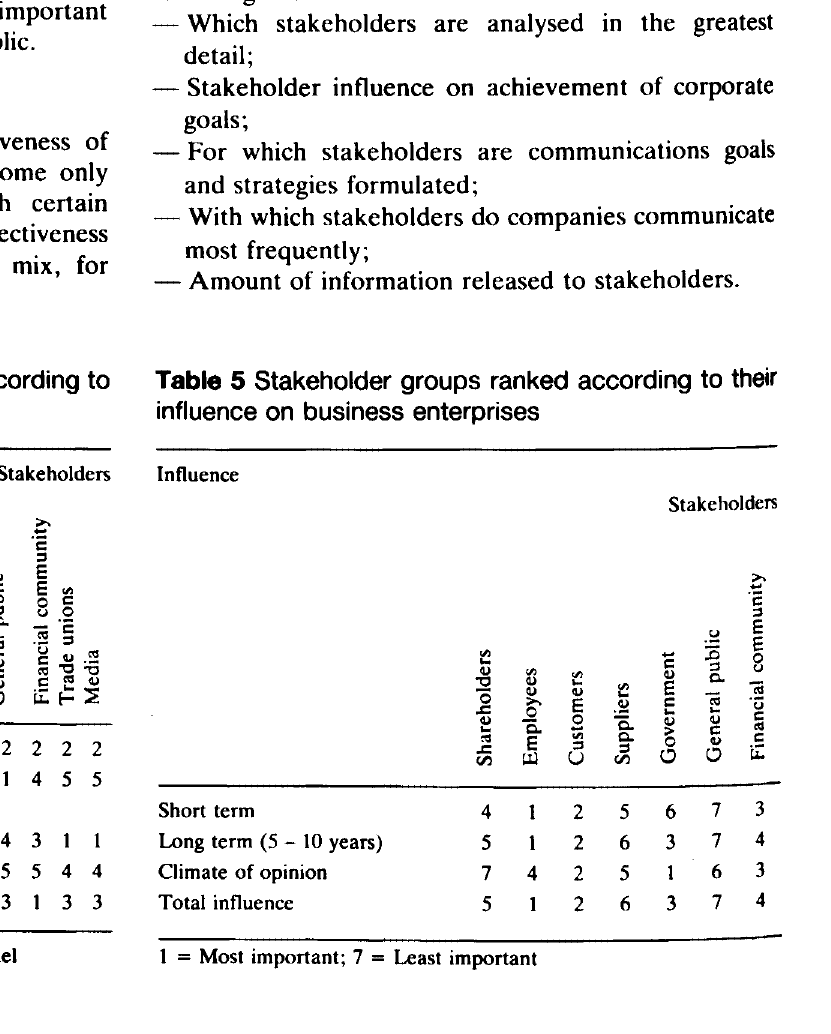
Table 4 Communication channels ranked according to